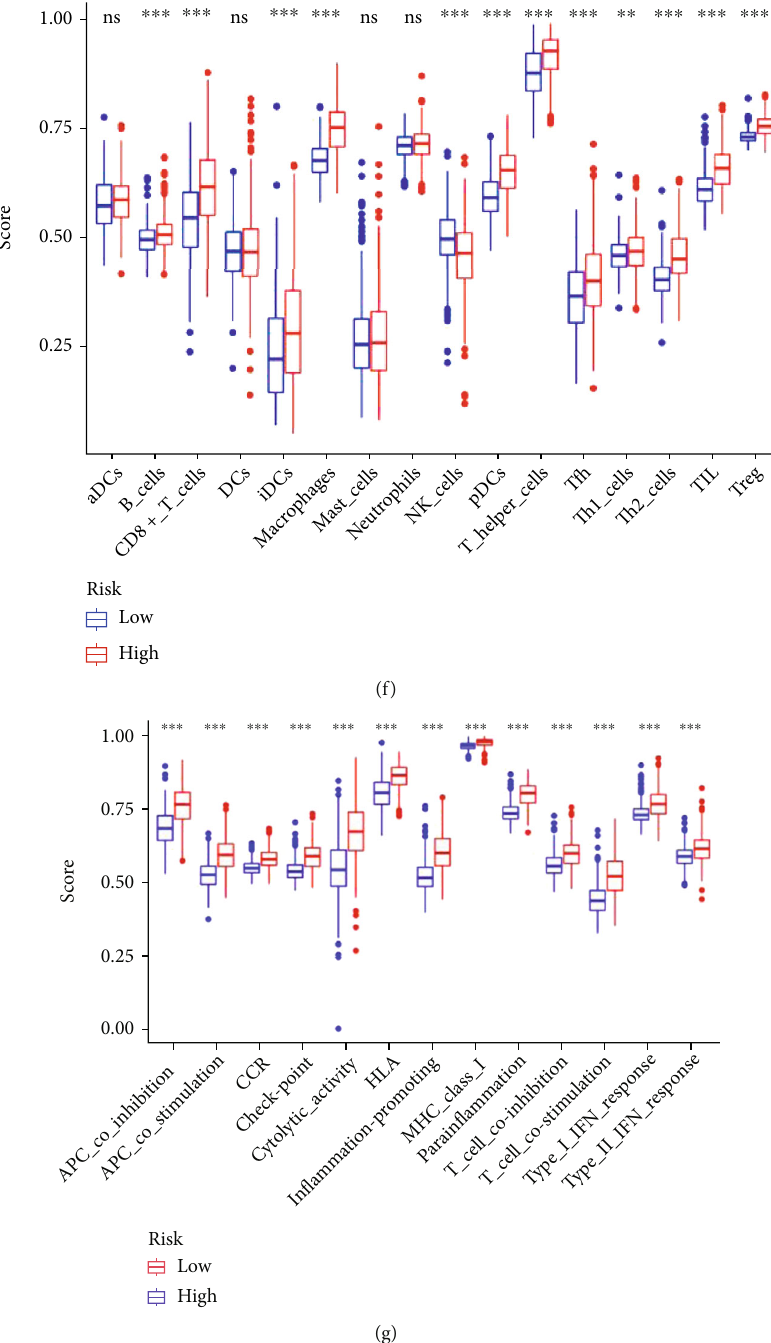
Figure 8: The immune status between di ff erent risk groups as analyzed in patients with glioma based on TCGA database. (a) The heat map shows the scores of 29 immune-associated gene sets between low- and high-risk groups by ssGSEA arithmetic. The violin plots display the di ff erences in (b) tumor purity, (c) ESTIMATE scores, (d) immune scores, and (e) stromal scores between low- and high-risk groups. (f) The expressions of 16 immune cells between low- and high-risk groups. (g) The expressions of 13 immune-related functions between low- and high-risk groups. ∗∗ P < 0 : 01 and ∗∗∗ P < 0 : 001 ; ns: no signi fi